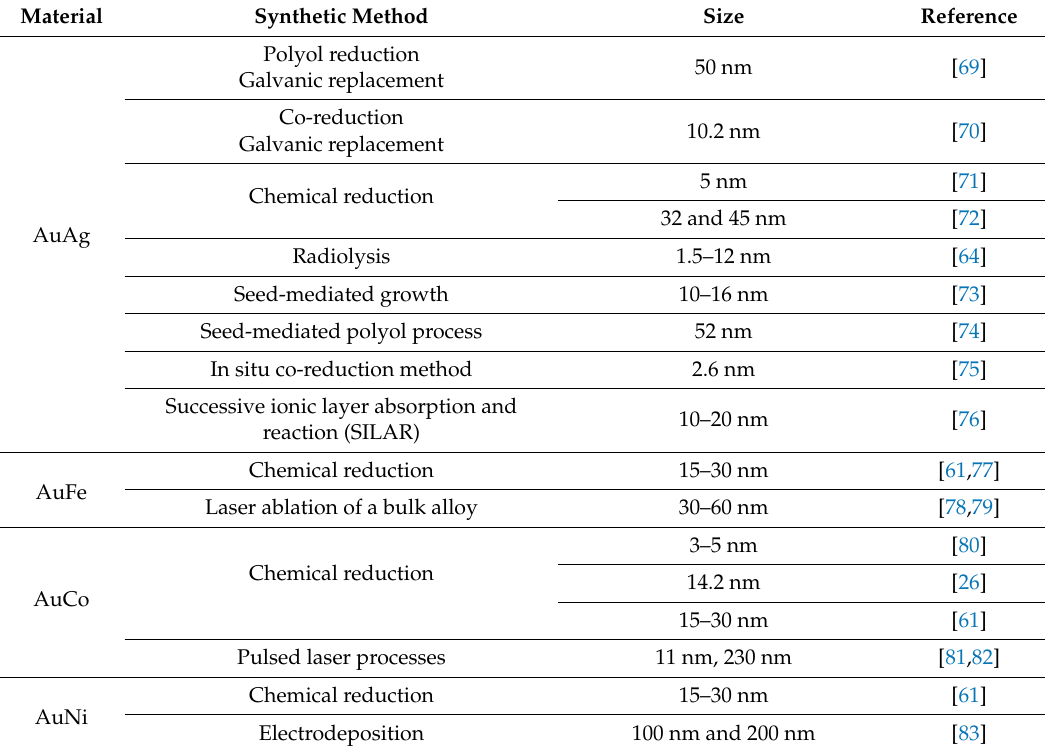
Table 1. Methods used for the synthesis of bimetallic nanoparticles.